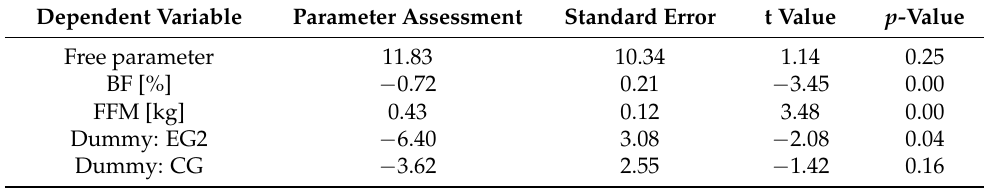
Table 8. Parameters of multiple regression model of the irisin (IR) dependent variable.